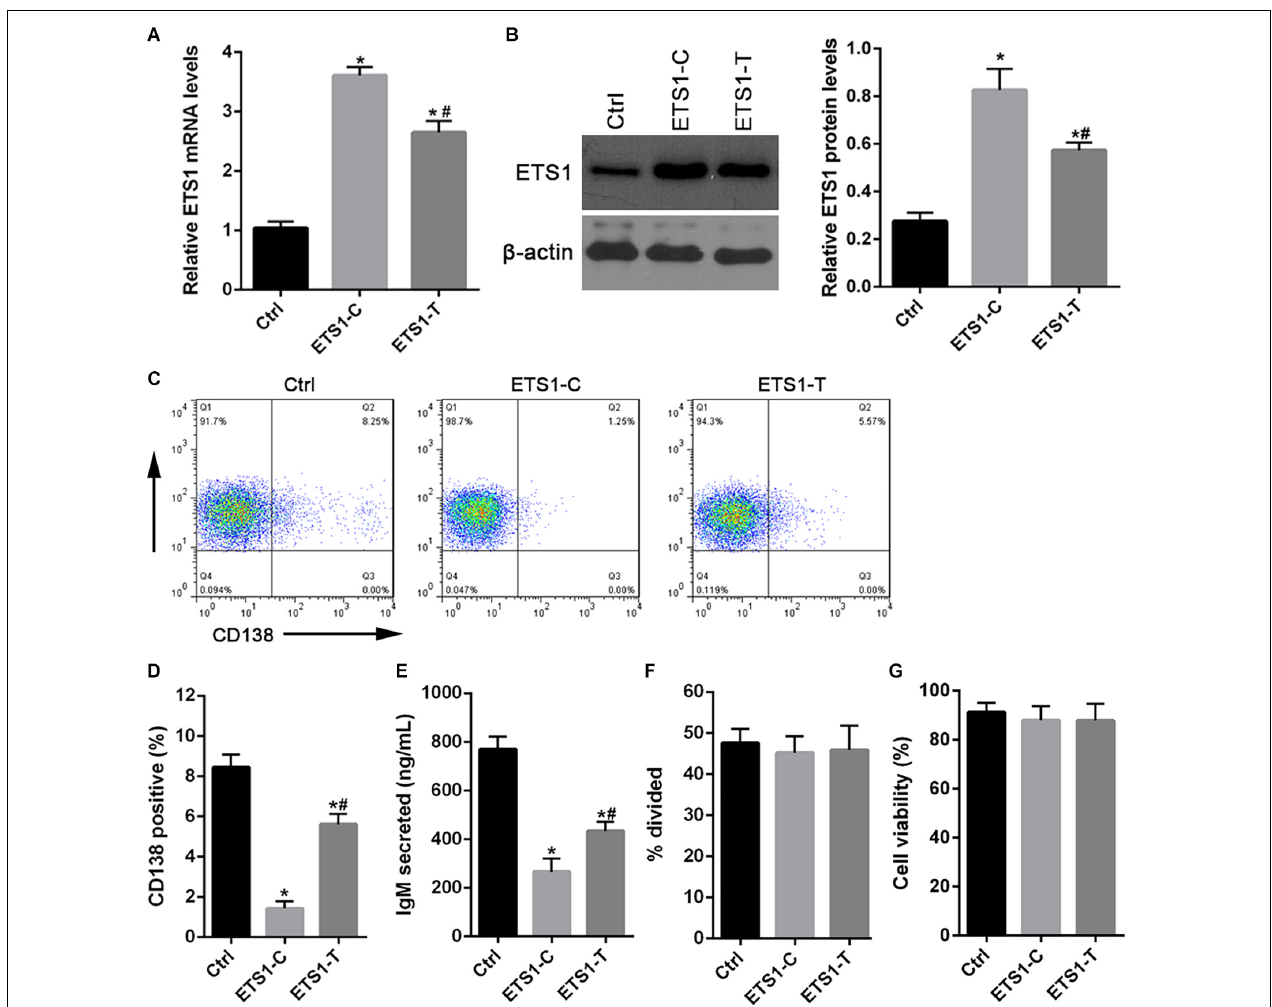
FIGURE 3 | Forced expression of ETS1 in primary B cells inhibits plasmacytic differentiation. (A,B) Lentiviral constructs used for transduction experiments and Western blot analysis of ETS1 levels in lentivirally infected B cells. (C) Flow cytometry analysis of lentivirally infected primary B cells. B cells were stimulated with CpG ODN, infected with lentiviral constructs, and returned to culture in the presence of CpG ODN. (D) Two days later, the cells were stained with anti-CD138 antibody and analyzed by flow cytometry to quantify plasma cell differentiation. (E) ELISA was performed to assess IgM secretion after GFP+ cells were lentivirally infected